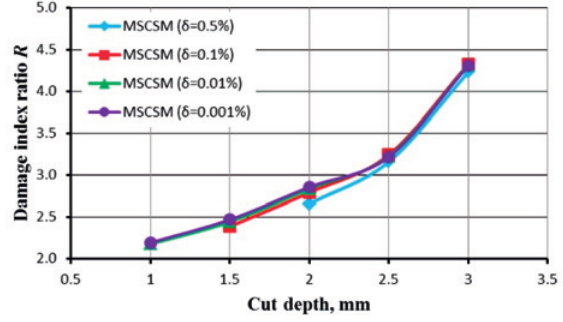
fig. 2. Damage index ratios for the MSCSM damage index